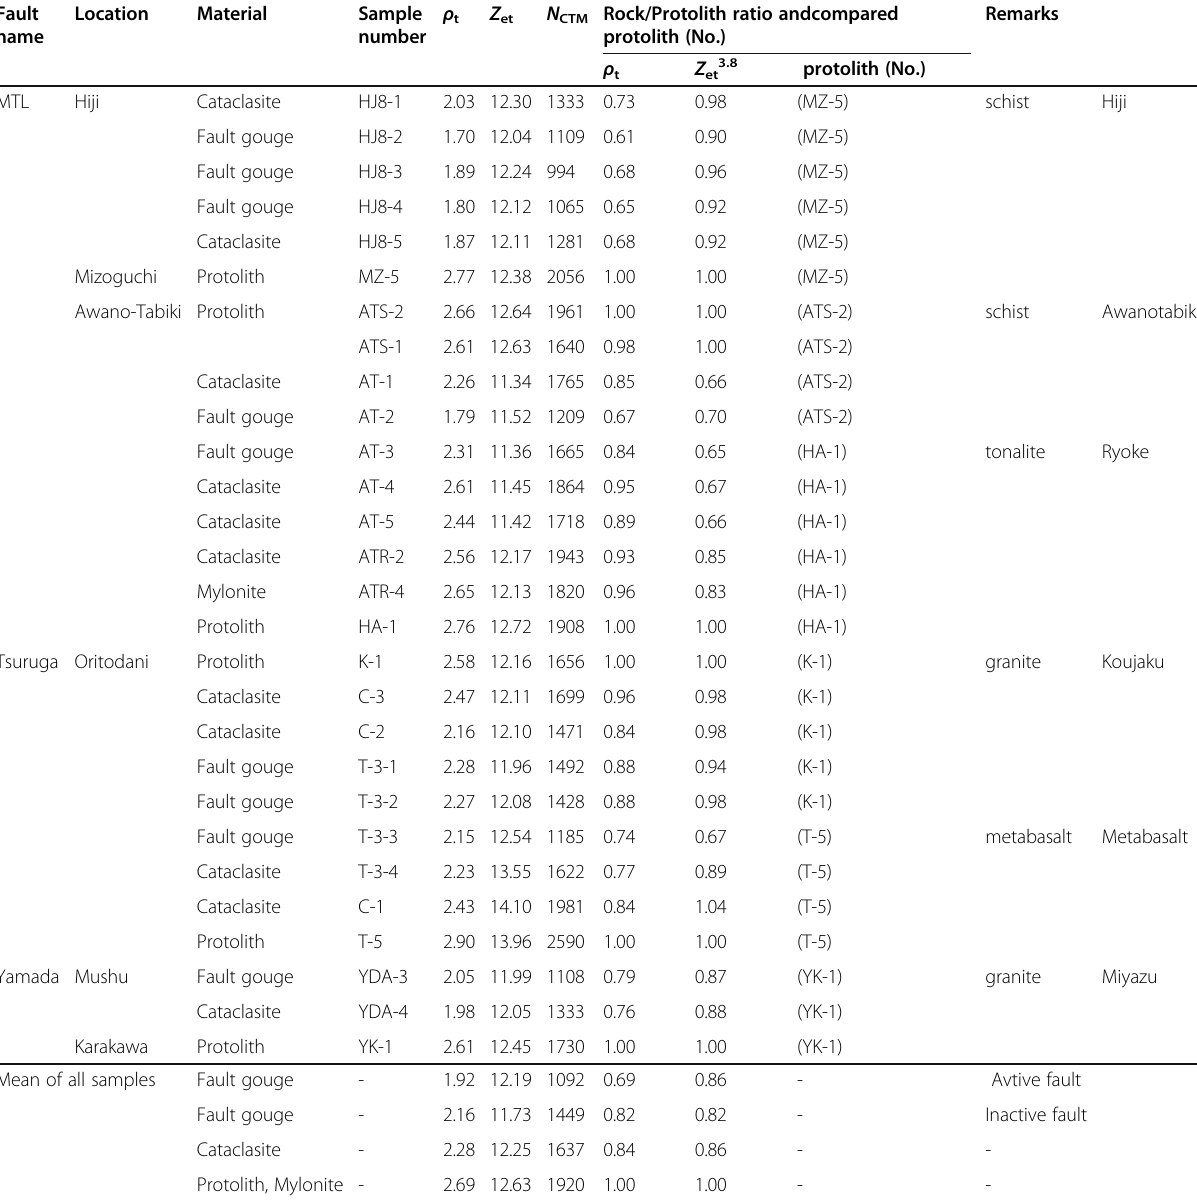
Table 5 Comparison of ρ t , Z et , N CTM , and the rock/protolith ratios ( ρ t and Z et3.8 ) for each of the analyzed samples Fault name